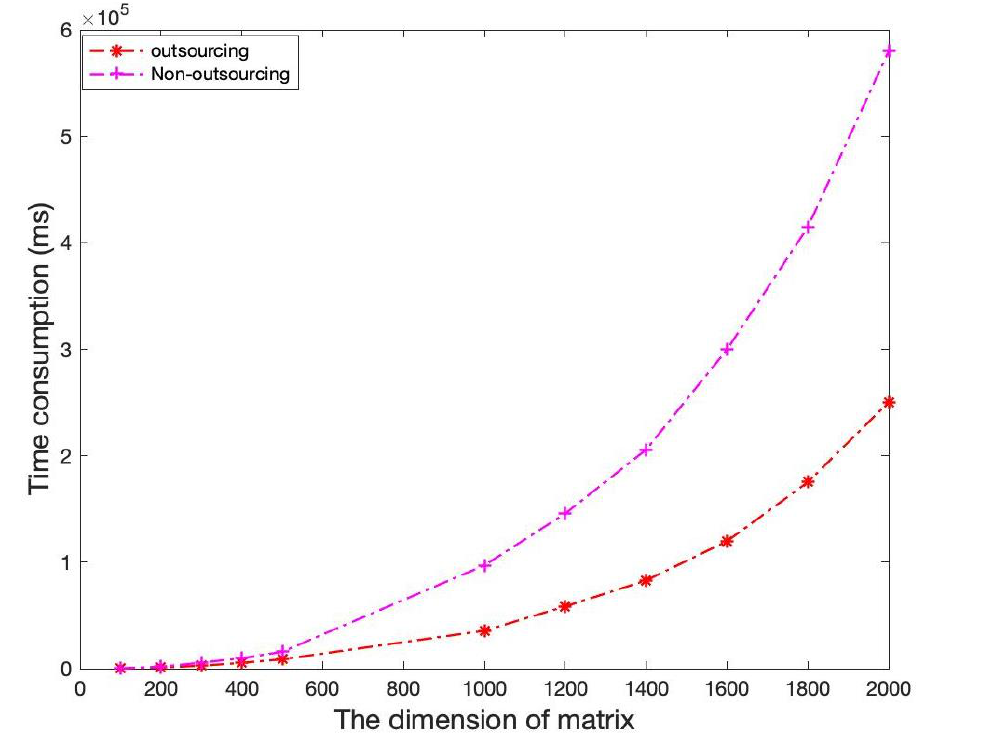
Figure 6. The time consumption of solving linear